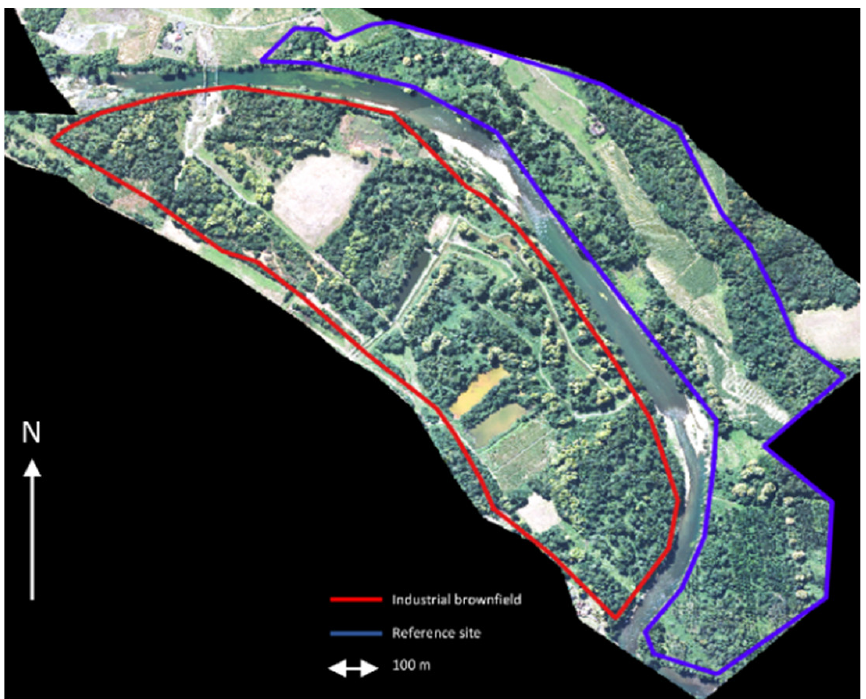
Figure 1. Study site’s location on a high-resolution orthophoto background (BD ORTHO ® 20 cm [68]): Industrial brownfield (surrounded in red) and reference site (surrounded in blue).